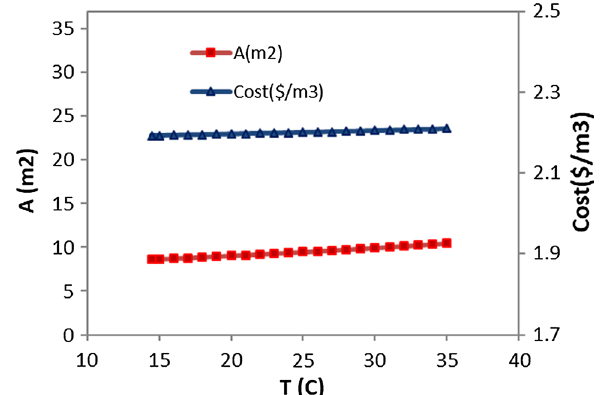
Fig. 5 Modeling the changes of the applied pressure versus cost and the active area of the membrane Fig. 6